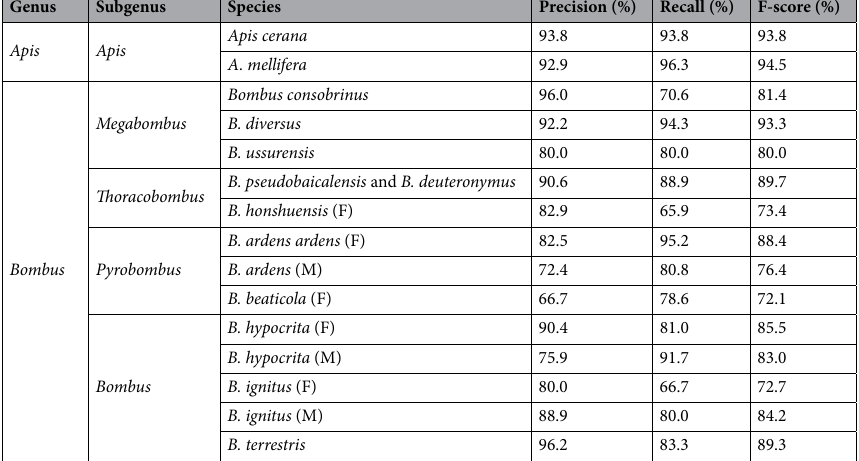
Table 3. Precision, recall, and F-score of species identification by Xception in color class experiment. F/M within a parenthesis represents female/male. Precision is the number of correct predictions as a certain class divided by the number of all predictions as the class returned by Xception. Recall, which is equivalent to sensitivity, is the number of correct predictions as a certain class divided by the number of test datasets as the class. F-score is the harmonic average of the precision and recall, (2 × precision × recall)/(precision +